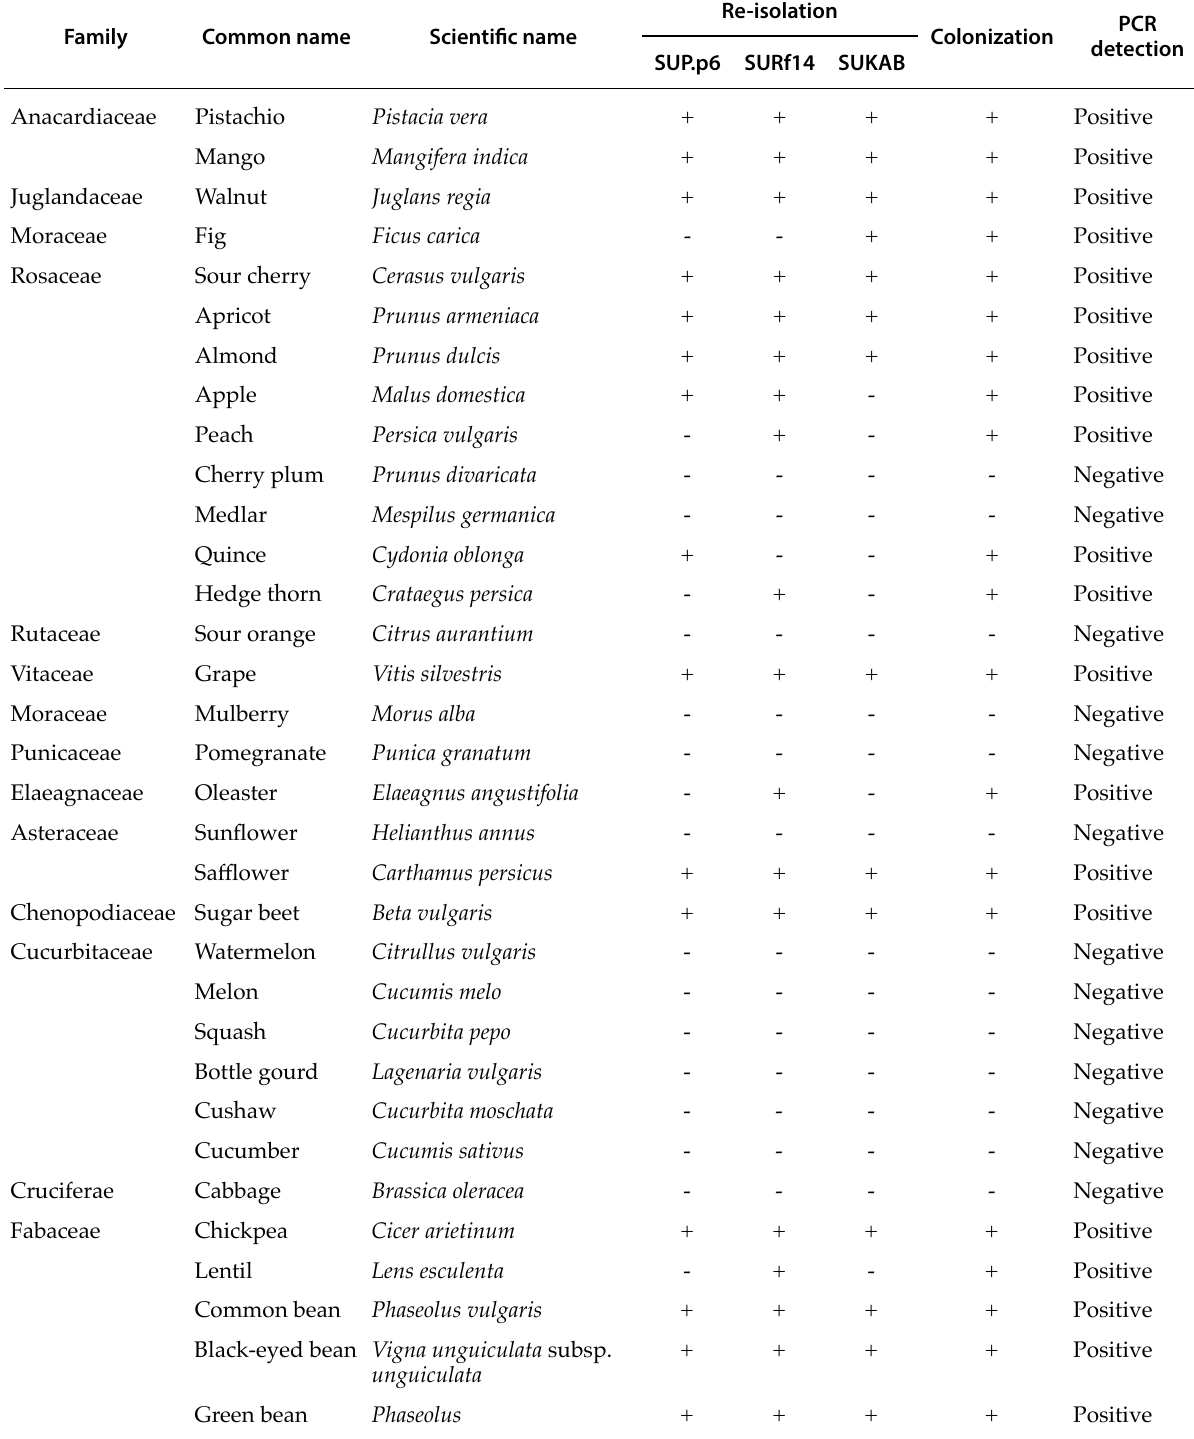
Table 2. Susceptibility of roots of annual and perennial plants to Phytophthora pistaciae isolates.